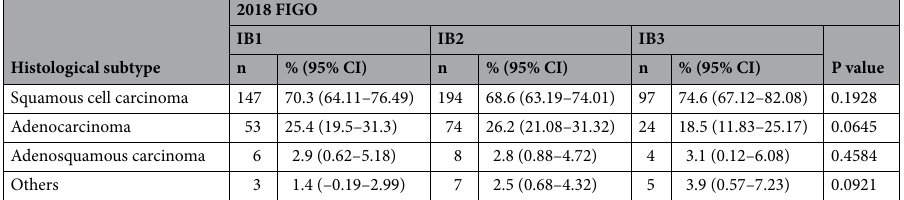
Table 2. The histological distributions of stage IB1/IB2/IB3 based on the 2018 FIGO stage. FIGO International Federation of Gynecology and Obstetrics.